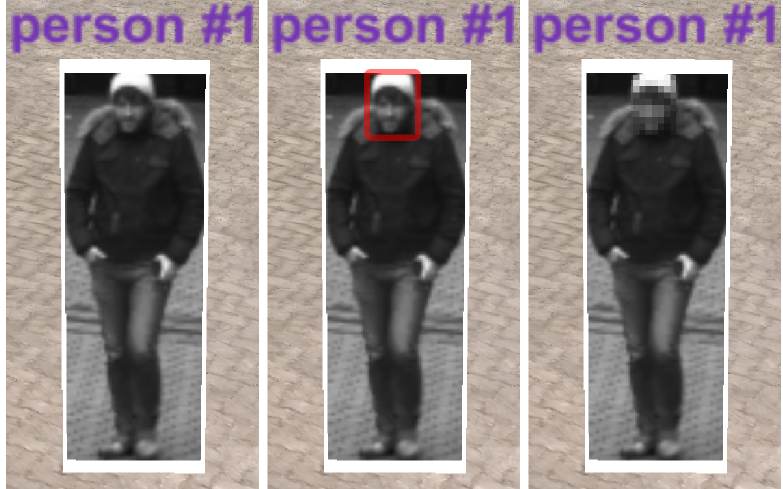
Figure 22. Faces of displayed persons within the 4D reconstruction can be anonymized for privacy reasons. A face detection algorithm detects the bounding boxes of faces ( center ) which are subsequently blurred in the displayed content throughout the visual analysis ( right